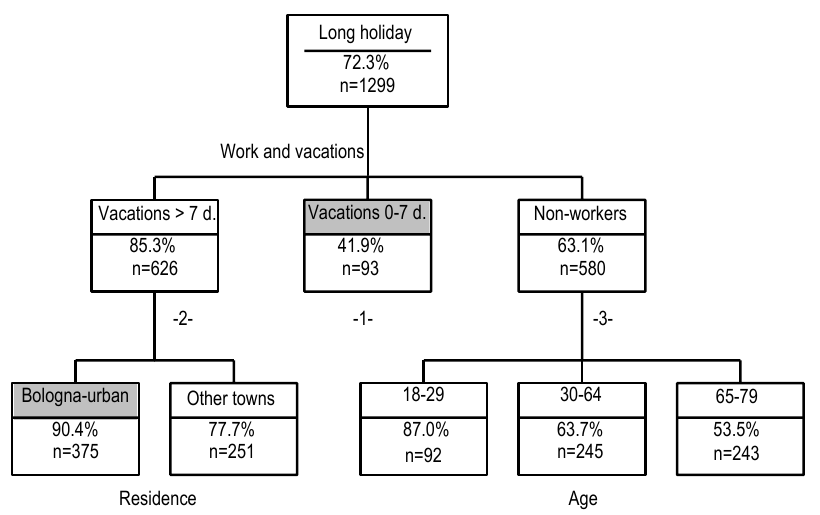
Figure 7 – Classification Tree of individuals that took at least one long holiday in 2004.